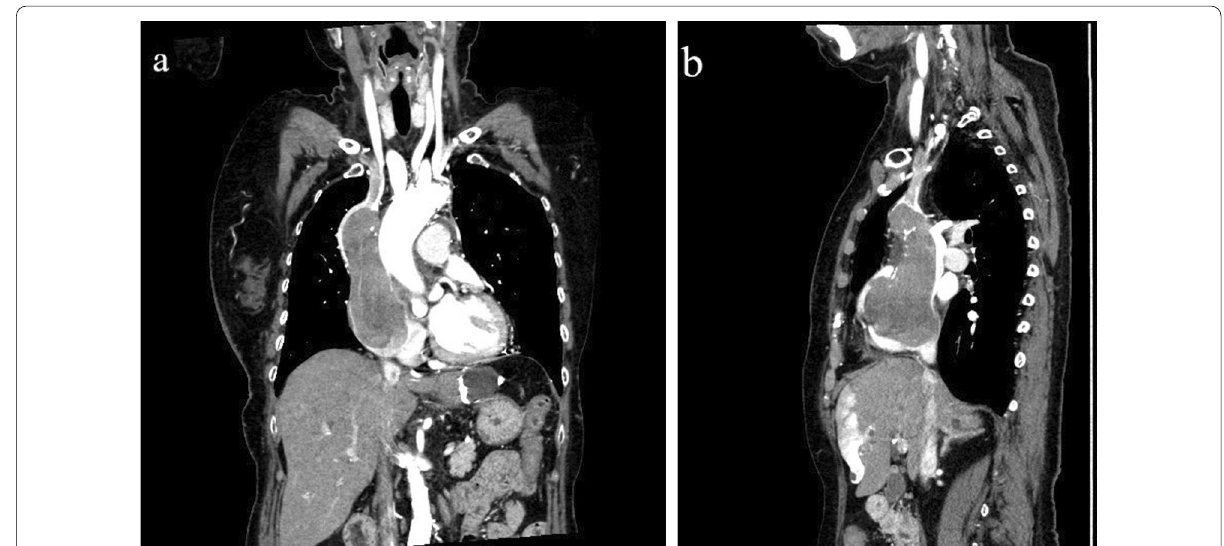
Fig. 1 Preoperative contrast-enhanced computed tomography shows a large mass in the right atrium extending to the superior vena cava and left brachiocephalic vein. a Coronal view; b sagittal